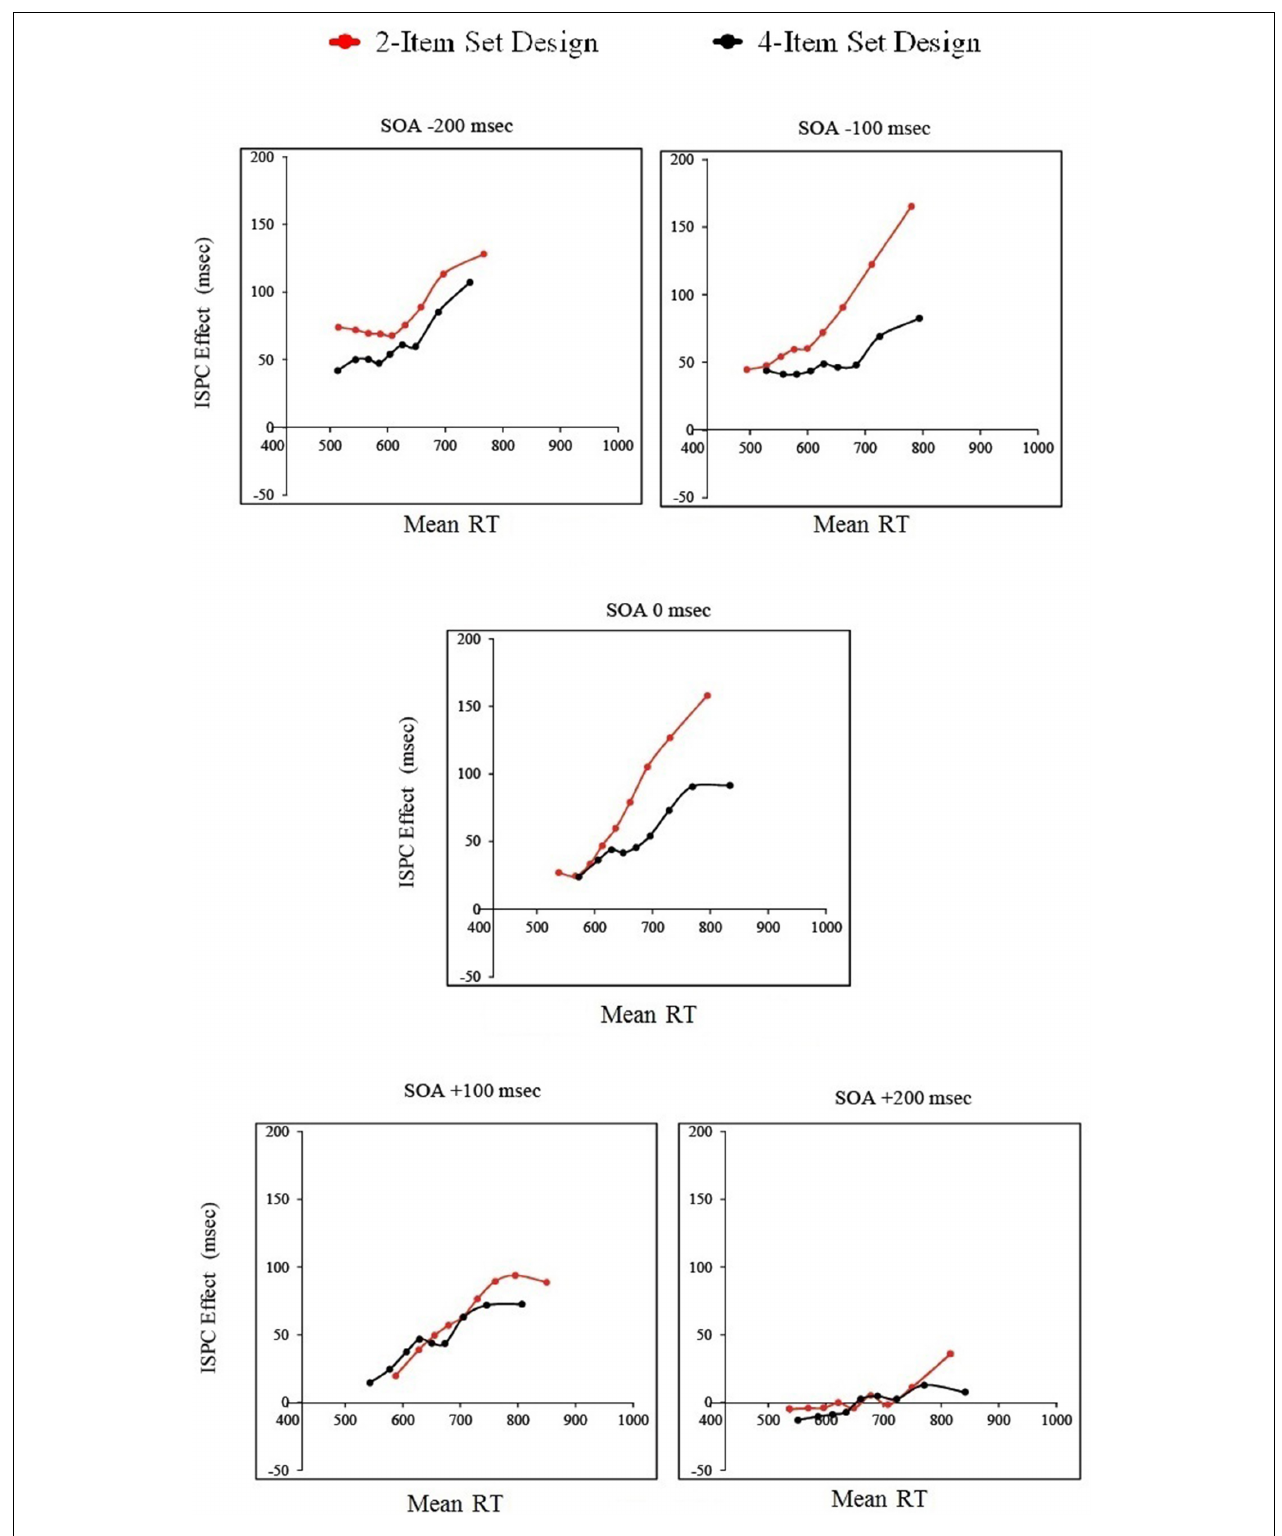
FIGURE 9 | Delta plots of the ISPC effects as a function of set size and SOA for Experiment 2.